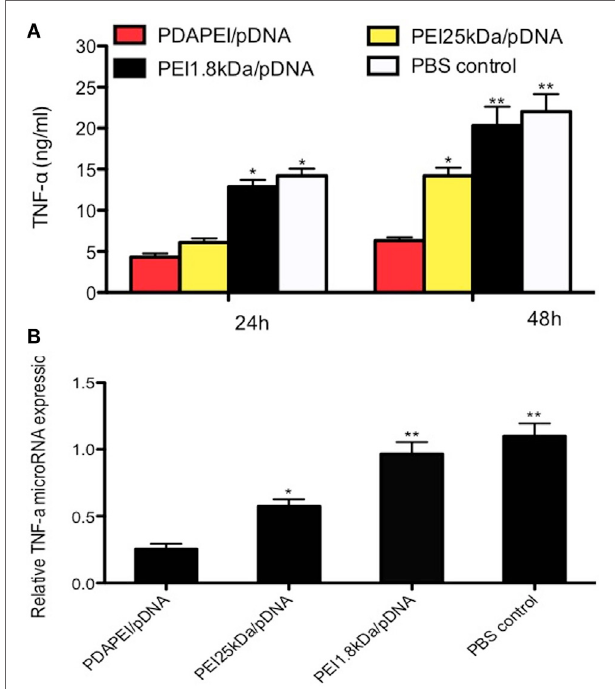
FigUre 4 | expression of TnF- α in vitro . (a) TNF- α expression of RAW246.7 cells determined by ELISA measurement 24/48 h after transfected with TNF- α shRNA by different polymers. (B) Relative levels of TNF- α mRNA expression was corrected by GAPDH. Data represent fold change of relative TNF- α expression normalized to GAPDH levels. (* p < 0.05, ** p < 0.01).